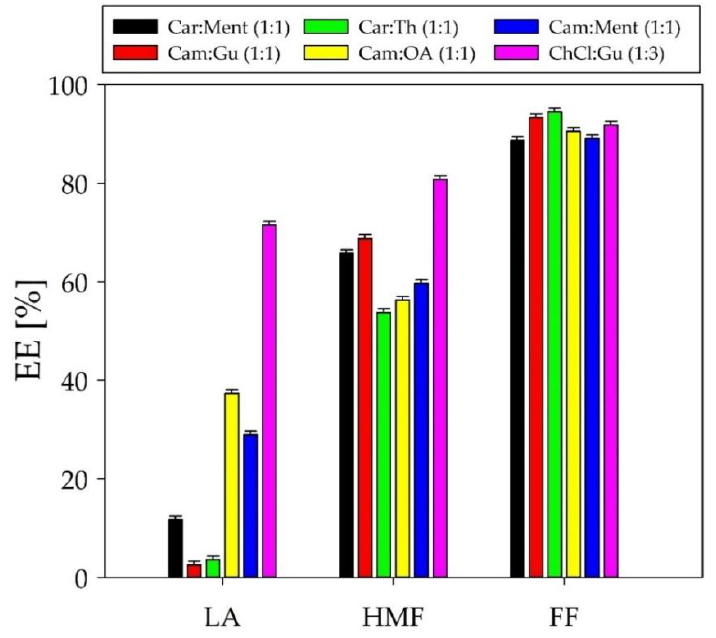
Figure 5. The effect of type of DES on extraction efficiency with respect to LA, HMF, and FF.